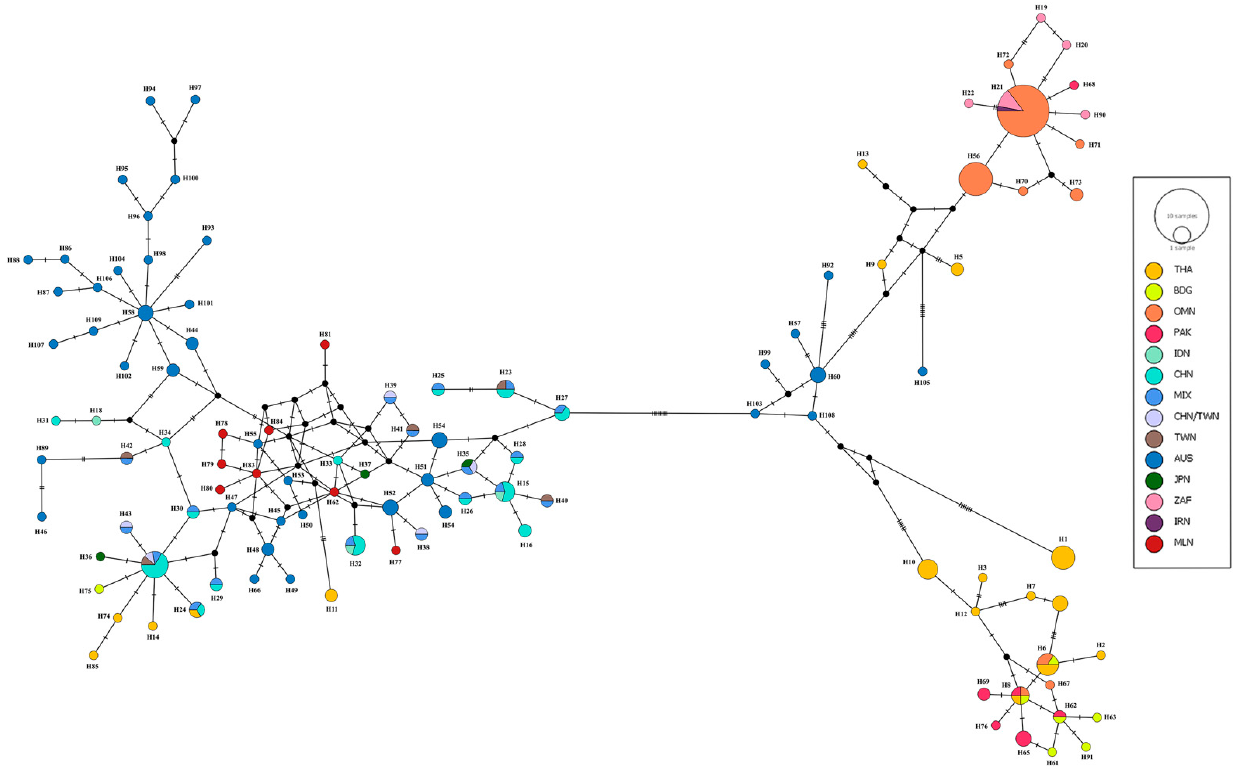
Figure 4. MJNs of mitochondrial DNA control region based on 256 bp from 232 sequences of T. aduncus . The MJNs are represented by 102 haplotypes found worldwide. Each haplotype is colored by geographic location.